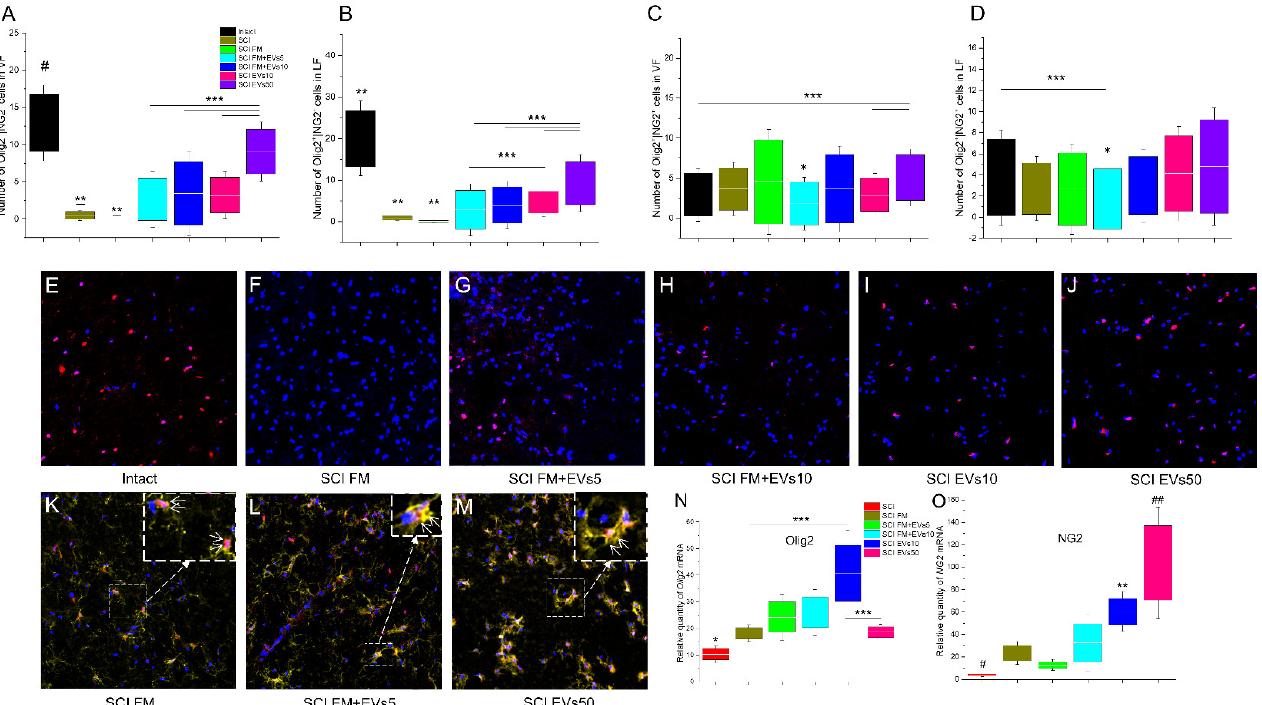
Figure 4. ( A – D ) Number of Olig2+/NG2- and Olig2+/NG2+ cells (Y axis) in control and experimental animal groups at 60 days after SCI. * p < 0.05—as compared with SCI FM+EVs10, SCI EVs10 and SCI EVs50; ** p < 0.05—as compared with all groups; # p < 0.05—as compared with SCI FM, SCI FM+EVs5, SCI FM+EVs10 and SCI EVs10; *** p < 0.05. ( E – J ) Panels illustrate Olig2+/NG2−-cells in intact rats ( E ), Olig2+/NG2−-cells at day 60 after fibrin matrix application ( F ), MSCs-EVs within fibrin matrix ( G , H ) and intravenous infusion of MSCs-EVs in saline ( I , J ) in LF zone of spinal cord. ( K – M ) Panel illustrates Olig2+/NG2+-cells on day 60 after application of fibrin matrix ( K ), MSCs-EVs within fibrin matrix ( L ) and intravenous infusion of MSCs-EVs in saline ( M ). The zones highlighted with dashes correspond to each other, and the arrow points to the enlarged image of the corresponding zone. Arrows indicate Olig2+/NG2+-cells. Scale bar: 20 μm. ( N , O ) Relative quantity of Olig2 and NG2 mRNA expression at 60 days after SCI in experimental groups, calculated in relation to intact spinal cord controls, which were considered as 1. mRNA expression was normalized using 18s rRNA. * p < 0.05—as compared with SCI FM, SCI FM+EVs10, SCI EVs10 and SCI EVs50; ** p < 0.05—as compared with SCI FM and SCI FM+EVs5; # p < 0.05—as compared with SCI FM, SCI FM+EVs5 and SCI EVs10; ## p < 0.05—as compared with SCI, SCI FM and SCI FM+EVs5; *** p < 0.05. Prominent changes in the population of Olig2+/NG2+ cells were also found in the white matter. In the VF zone, there was an increase in the number of Olig2+/NG2+ cells in the group that received an intravenous injection of the maximum EV dosage (SCI EVs50), when compared to the other groups, with a significant difference when compared to the intact, SCI FM+EVs10 and SCI EVs10 groups (SCI EVs50: 5.07 ± 0.71 vs. Intact: 2.00 ± 0.63; SCI FM+EVs10: 3.67 ± 1.07 and SCI EVs10: 2.92 ± 0.54) (Figure 4C). In the LF zone, the smallest number of LF cells was found in the SCI FM+EVs5 group (Figure 4D,L). In other